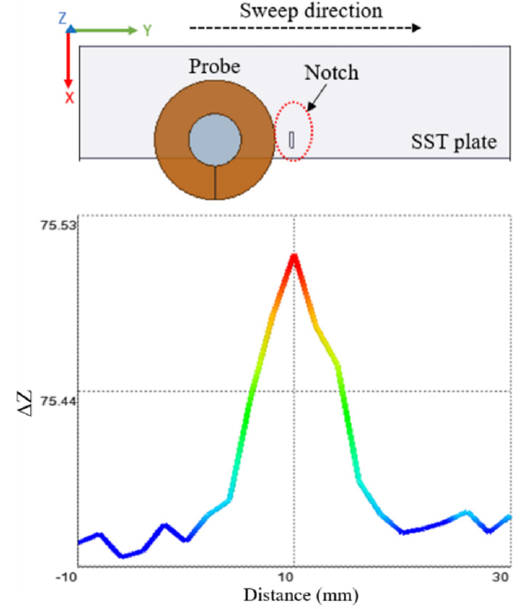
Figure 15. Subsurface notch close to an